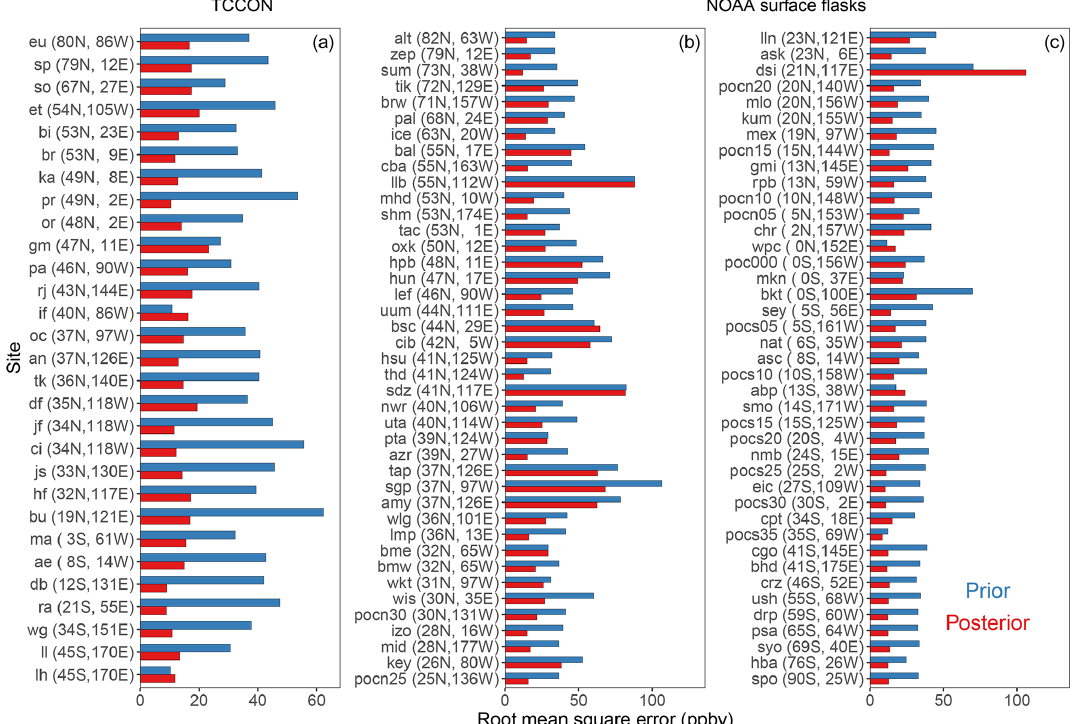
Figure 4. Root mean square errors of prior and posterior GEOS-Chem simulations relative to TCCON observations of dry column methane mixing ratios (a) and NOAA observations of surface air mixing ratios (b, c) . Observation sites are arranged by latitude. Data are for 2010– 2018. Site names are shown along with their latitude and longitude (more information about these sites can be found at https://tccon-wiki. caltech.edu/ – last access: 22 June 2020 and https://www.esrl.noaa.gov/gmd/dv/site/index.php?program=ccgg – last access: 22 June 2020). A mountaintop TCCON site located at Zugspitze, Germany (zs; ∼ 3000ma.s.l.), is excluded because the terrain effect on the total column is not resolved by the coarse-resolution model.